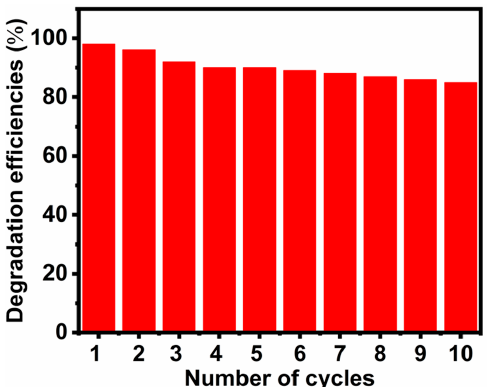
Figure 6. Recyclability study of the activated carbon until 10 consecutive cycles for the degradation of RhB.